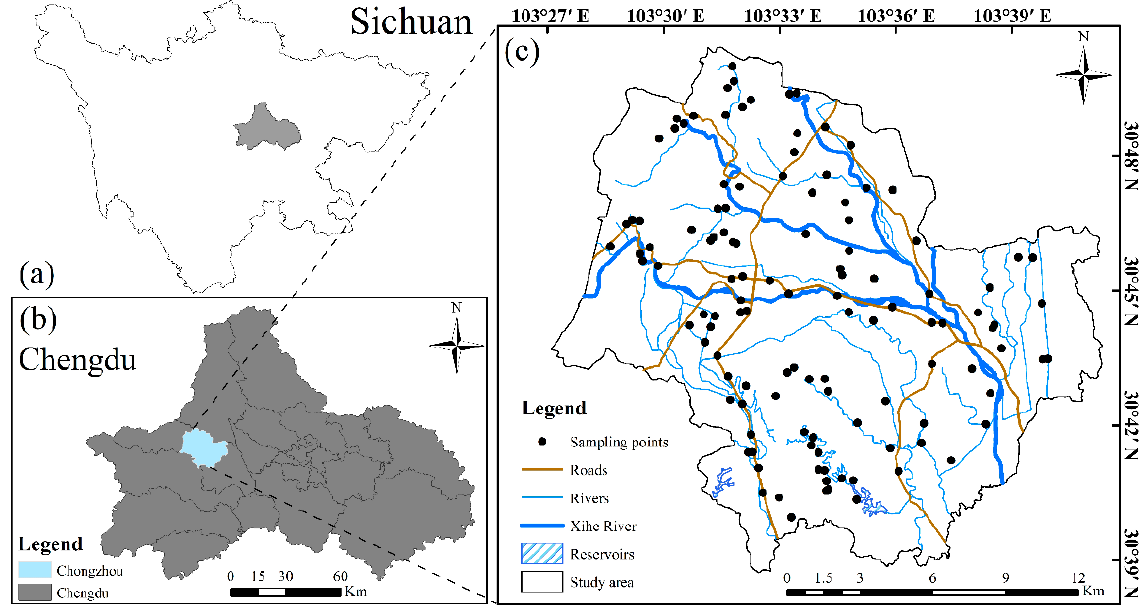
Figure 1. Location of the study area ( c ) in the city of Chengdu ( b ), Sichuan Province ( a ), China, and the spatial distribution of the sampling points.